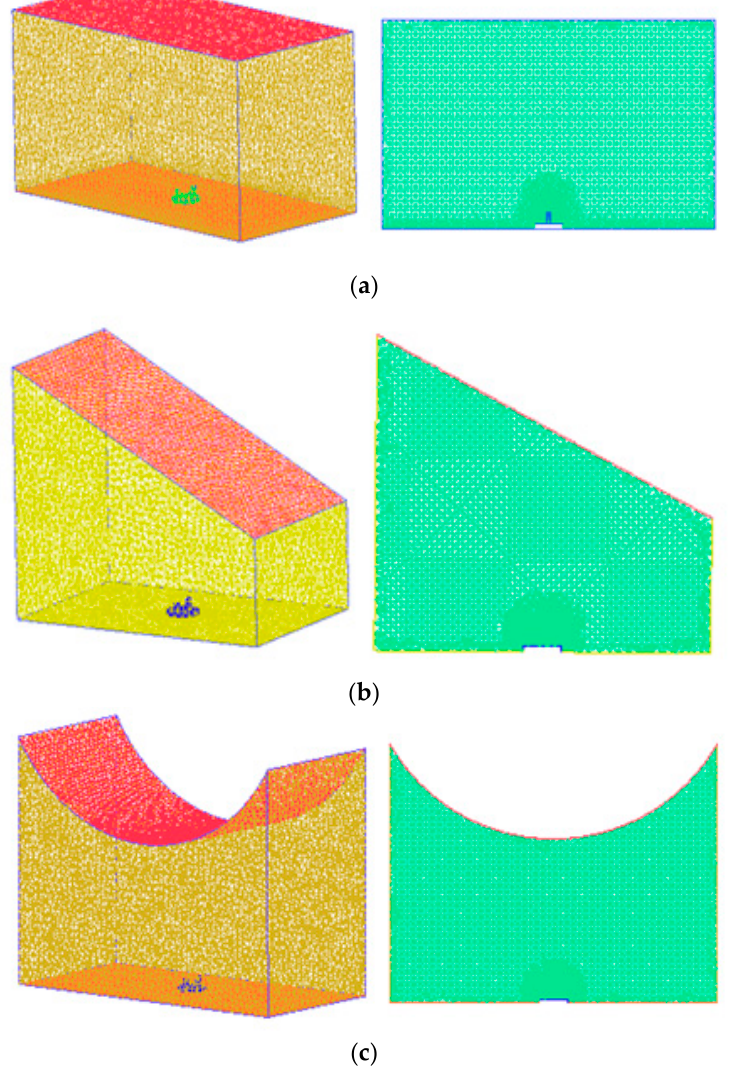
Figure 3. Mesh of air spray gun atomization flow field: ( a ) planar vertical spraying; ( b ) planar tilted spraying; ( c ) cylindrical spraying.